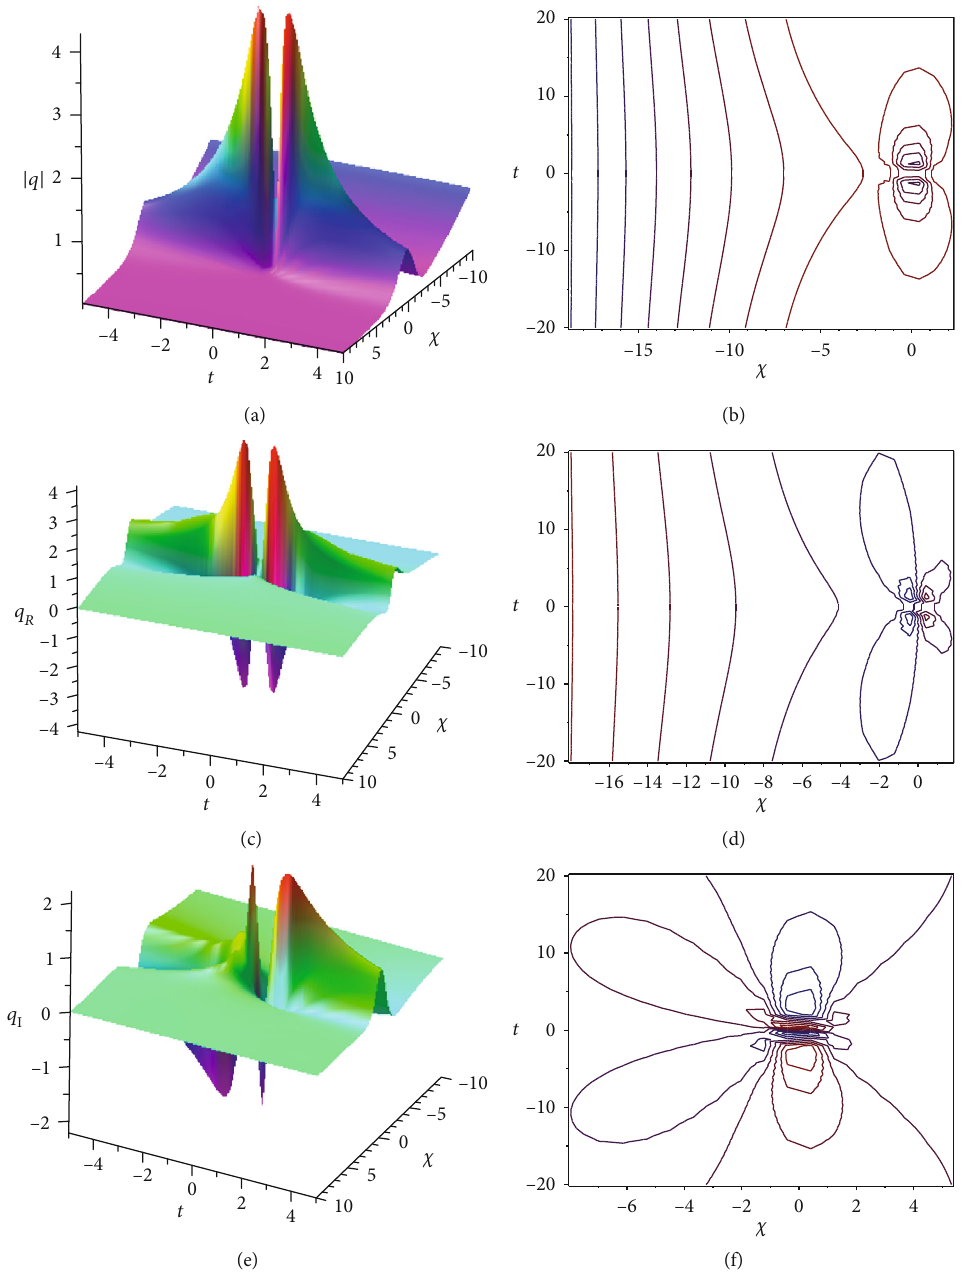
Figure 2: The two-fold particular solution evolution graph of (21) with parameters: ε = 1, a = 0 : 1, b = 0 : 2, c = 0 : 01, d = 0 : 35 . (a) ∣ q ½ 2 (cid:2) ∣ . (c) Re ð q ½ 2 (cid:2) Þ . (e) Im ð q ½ 2 (cid:2) Þ . (b, d, f) Contour plots corresponding to (a, c, e),